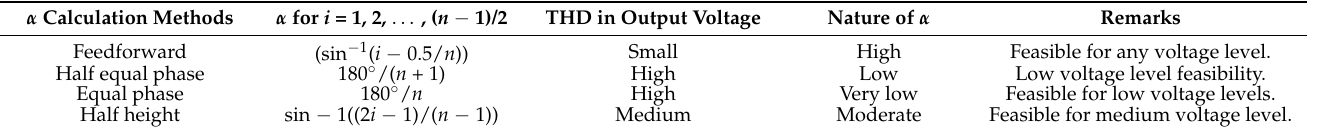
Table 4. Comparison of several switching angle computation